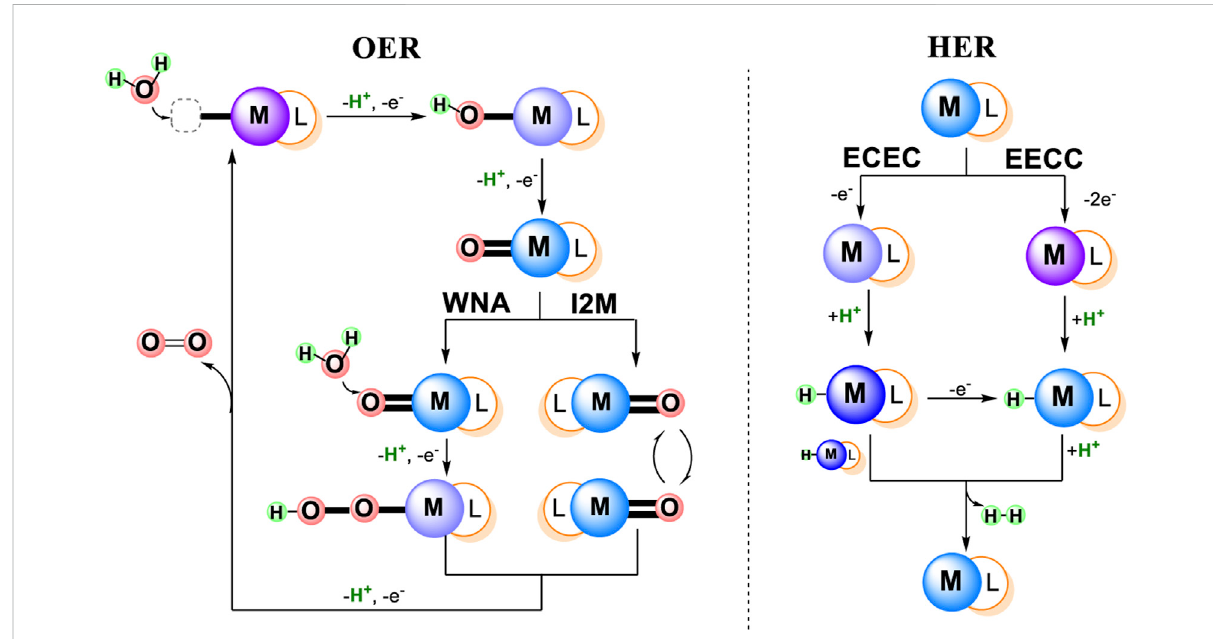
FIGURE 1 Schematic representation of general mechanisms for Water Oxidation and Water Reduction catalyzed by metal